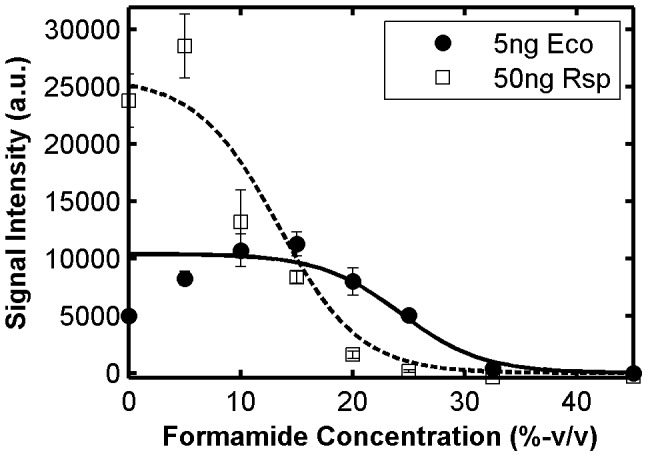
Formamide denaturation profiles with conventional target and highly abundant non-target.The example probe, E751–772, is a perfect match to the 16S rRNA gene of E. coli and has one mismatch to R. sphaeroides. Curves are theoretical predictions fitted to the experimental scale. Eco, E. coli; Rsp, R. sphaeroides.